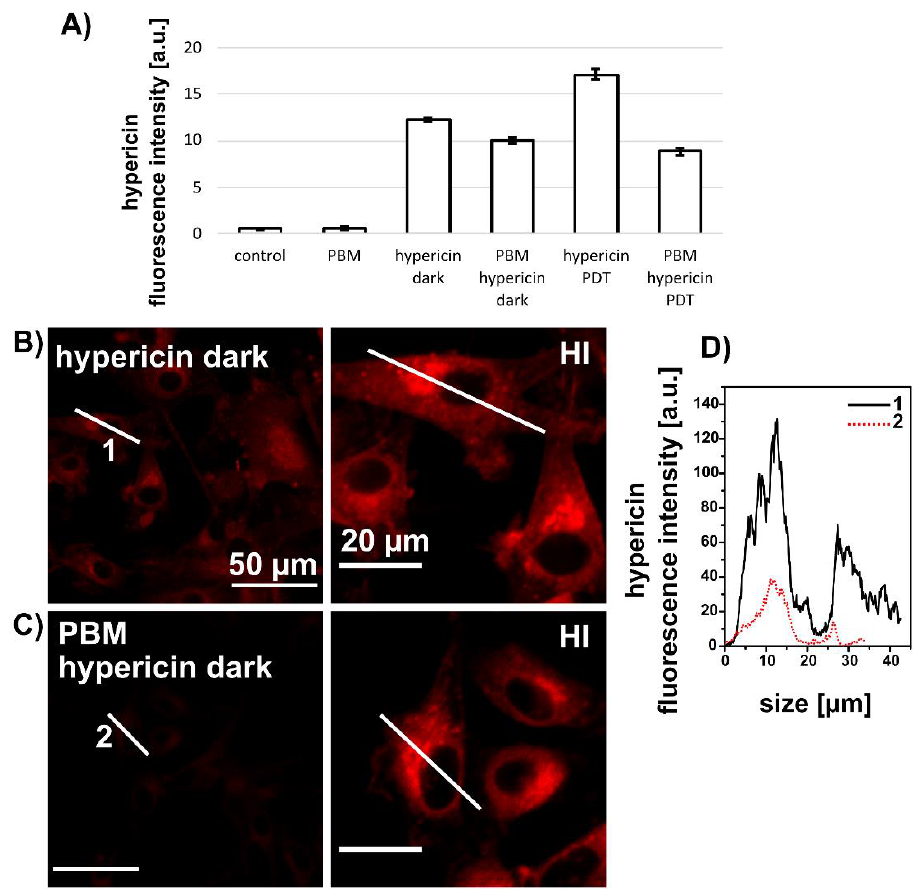
Figure 3. ( A ) Fluorescence intensity of 200 nM hypericin detected by flow cytometry in U87 MG cells under different conditions. Detection was performed 5 h after PDT. ( B ) Fluorescence distribution of 200 nM hypericin (3 h) in cells without and ( C ) with PBM. HI indicates high intensity correction to allow localization of hypericin. Scale bar—50 µ m. White lines were drawn along selected cells to show the distribution of the hypericin fluorescence intensity in the cell along these lines. ( D ) Representative fluorescence distribution along lines 1 and 2 shown in ( B , C ), respectively.